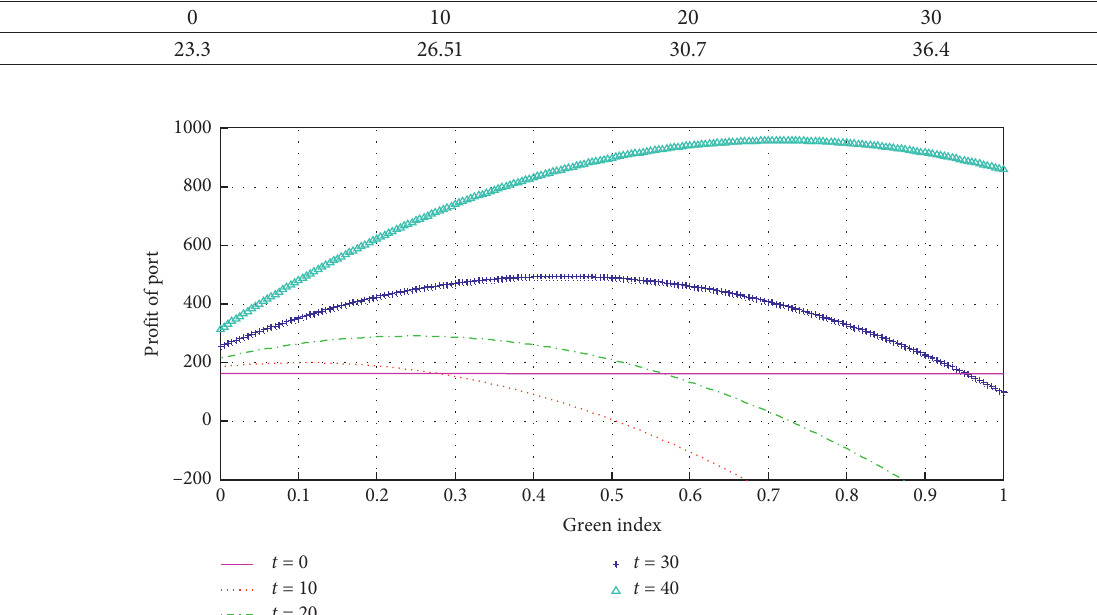
Figure 2: Profit of shipping company under different levels of the green index. Table 3: Optimal order quantity under different subsidy coefficients of the government.